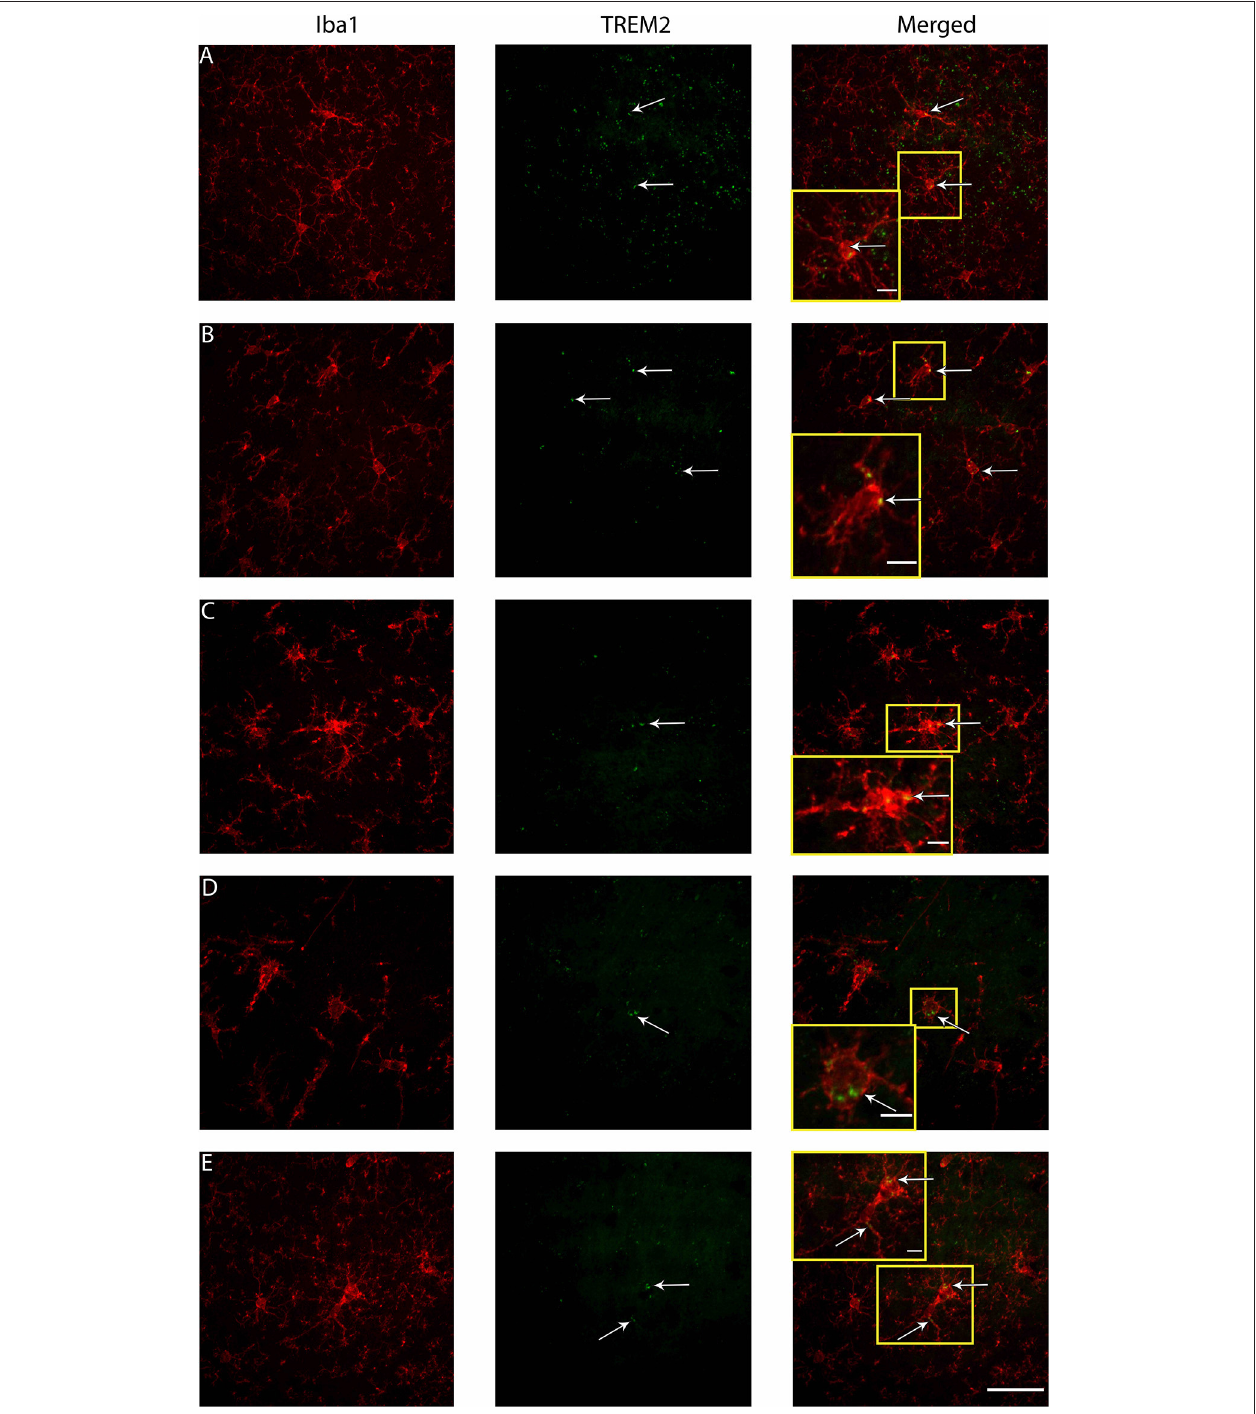
FIGURE 9 | Examples of microglial morphologies in colocalization with TREM2 in the S1BF of rats brain-injured at 6-months of age. Representative images of microglial morphologies were taken in the primary sensory barrel field (S1BF) of rats injured at 6-months of age; ramified (A) , hyper-ramified (B) , deramified (C) , amoeboid (D) , and rod (E) , and their colocalization with TREM2 indicated with the white arrows (scale bar = 50 µ m, inset = 10 µ m). in the gray and white matter that is equivalent to that observed of pathology was greater in all brain-injured groups, regardless of with a TBI in adulthood. The proportion of deramified microglial age-at-injury, compared with naïve. These findings indicate that a morphologies, indicative of microglial activation, was also greater brain-injury in early-life may harbor detectable neuropathology